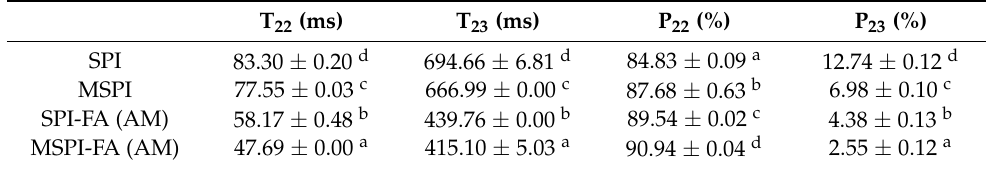
Table 6. Water state of emulsion gels induced by different modified soybean protein